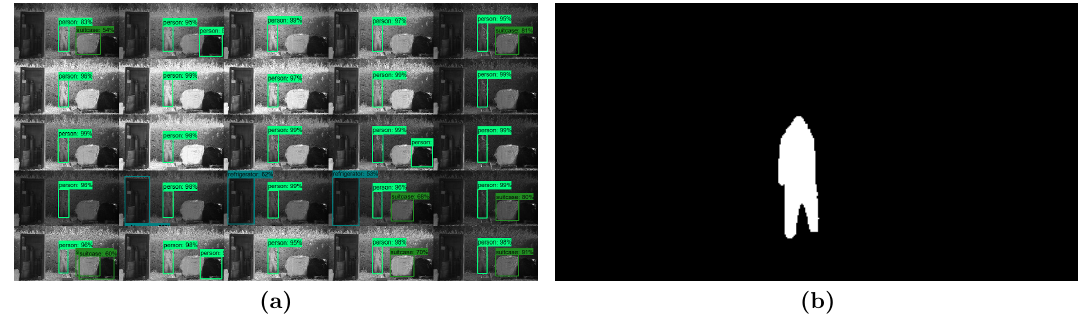
Figure 7. Automatic annotation: ( a ) MaskRCNN object detection in 25 spectral bands. ( b ) Merged mask of all MaskRCNN detections (magnified).